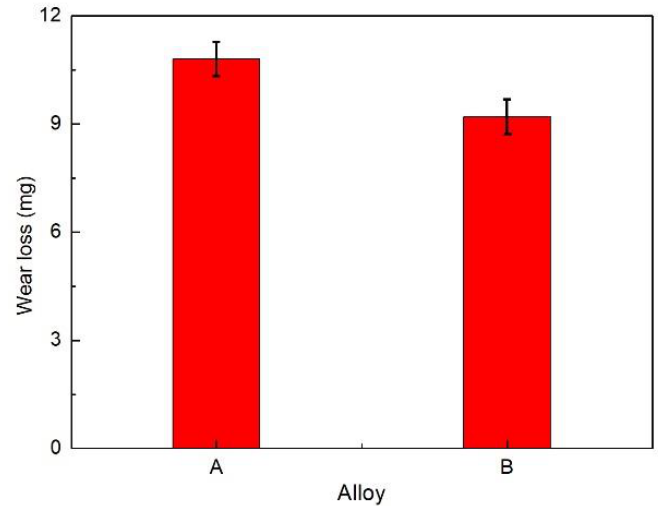
Figure 12. Wear loss of alloy A and alloy B.